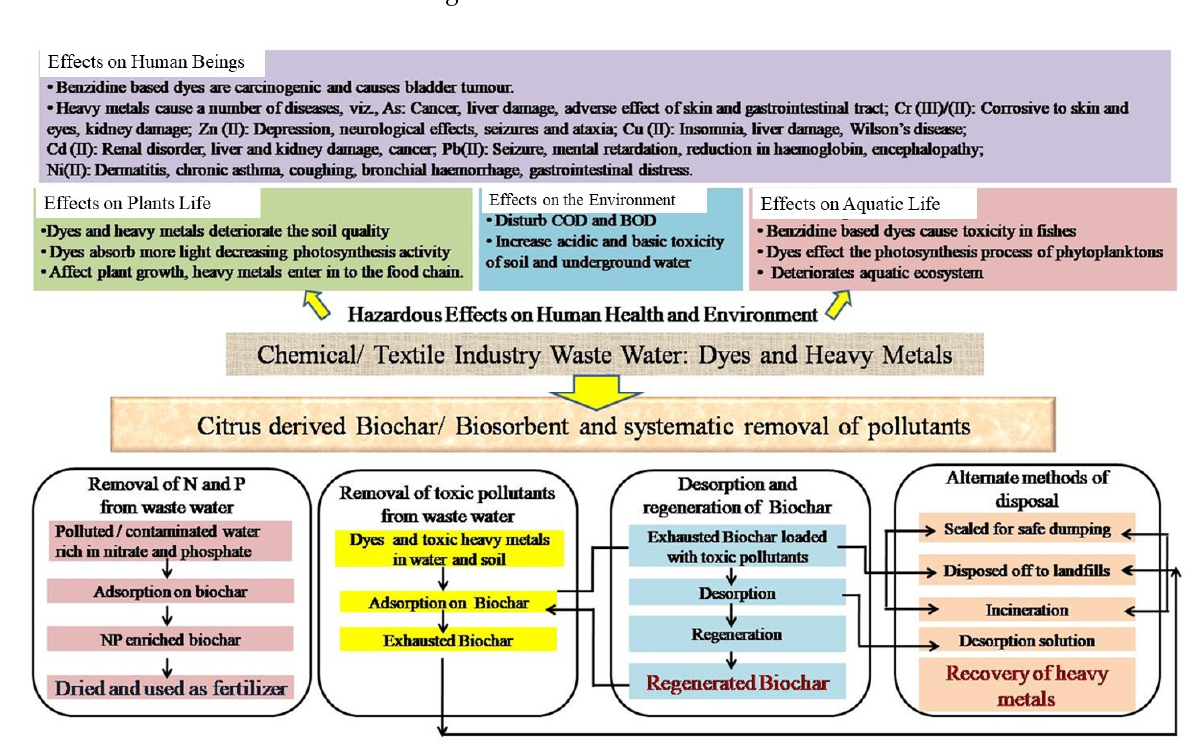
Figure 3. Structures of the anionic and cationic dyes.